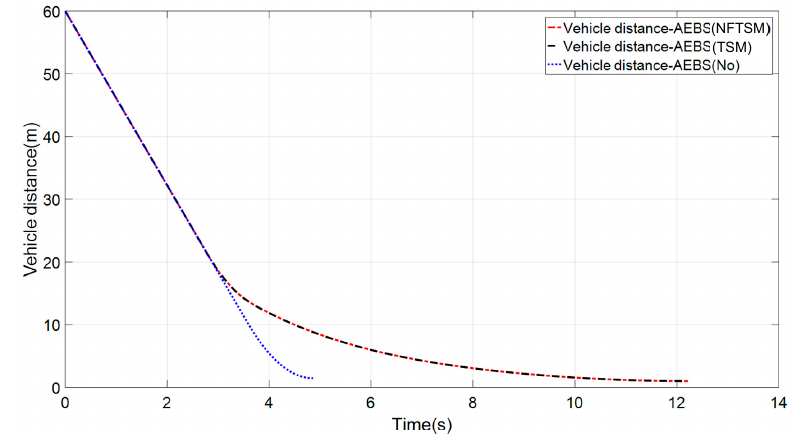
Figure 13. Comparison of relative distance.